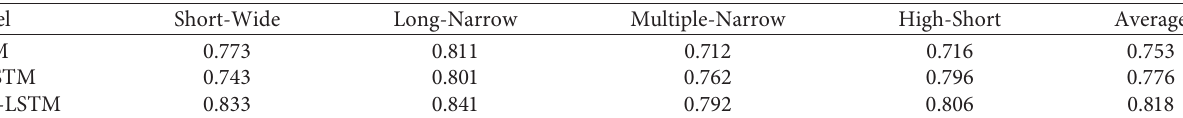
Table 2: Accuracy of the presented method; with the same fracturing operation parameters, the simulation was made on Fracpro PT (Figure 13).